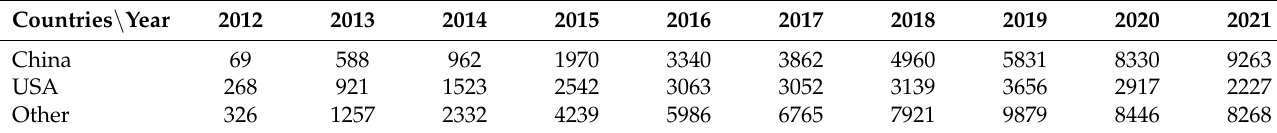
Table 4. The number of research publications in Big Data per year for different geographic regions.